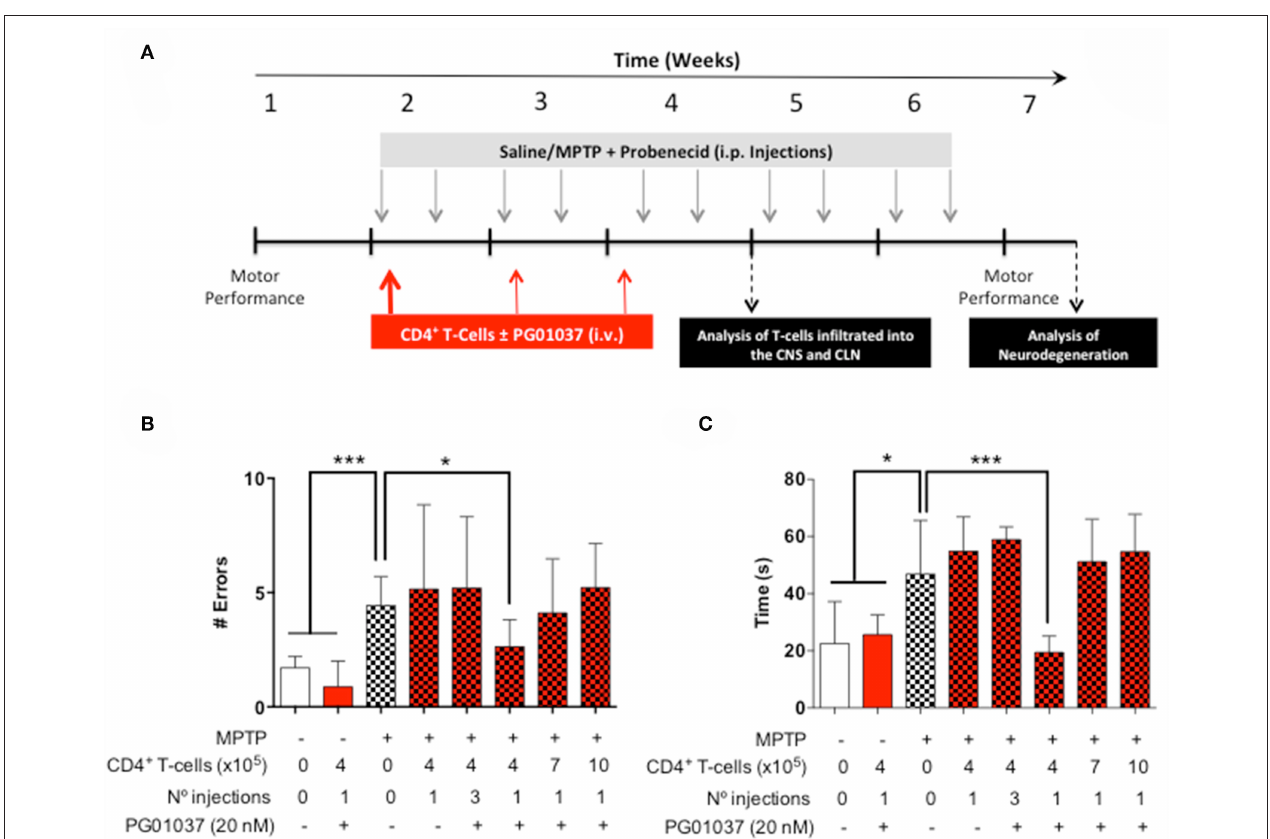
FIGURE 2 | Evaluation of the therapeutic potential of CD4 + T-cells treated ex vivo with a DRD3 antagonist in the motor performance of MPTPp-treated mice. (A) Experimental design: Control animals (without MPTPp treatment) were treated with saline, probenecid, and with or without the i.v. injection of CD4 + T-cells treated ex vivo with PG01037. MPTPp animals received 10 i.p. injections with MPTP (20 mg/kg) and probenecid (250 mg/kg) during weeks 2–6 (grey arrows). CD4 + T-cells (4 × 10 5 , 7 × 10 5 , or 10 × 10 5 per mouse) were treated with or without PG01037 (20nM) and then i.v. injected in experimental animals 1 day after the first MPTPp injection (bold red arrow). In some cases, animals received 3 injections of CD4 + T-cells separated by 1 week intervals (bold and thin red arrows). T-cell infiltration was analysed after 3 weeks of MPTPp-treatment. Neurodegeneration was analysed 1 week after the last MPTPp injection. Motor performance was analysed the week before beginning with MPTPp administration to distribute experimental groups with homogeneous motor performance and then it was evaluated again 16h after the last MPTPp injection in the Beam-test (B) and in the coat-hanger test (C) . Experimental groups receiving i.v. injections of CD4 + T-cells are indicated in red bars. Data represents the mean with the SEM. One-way ANOVA followed by Tukey’s multiple comparison post hoc test were used to determine statistical differences: * p < 0.05 *** p < 0.001, n = 5–17 mice per